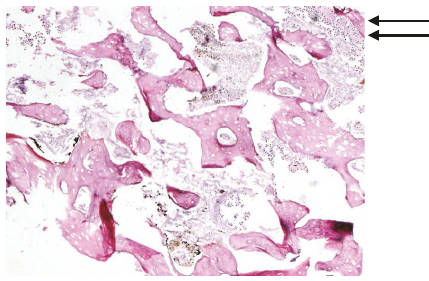
Figure 2: Histological section demonstrating mature bone with inflammatory